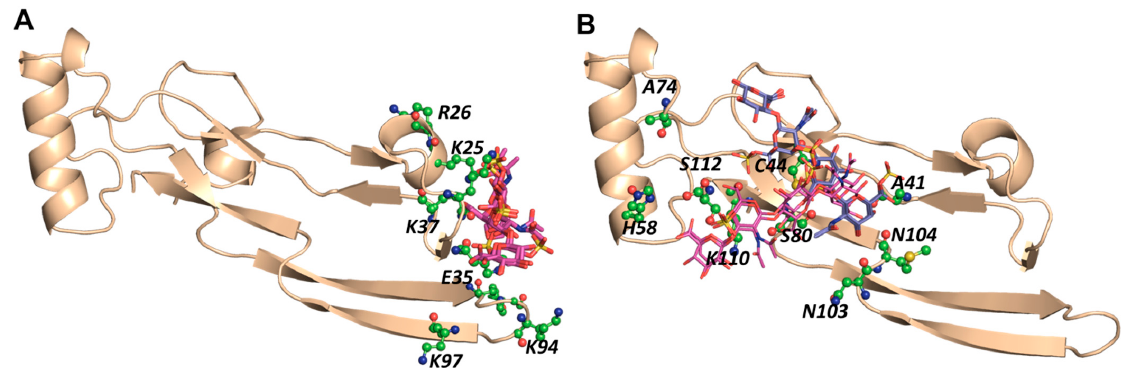
Figure 4. CVLS-predicted tetrasaccharide sequences from the Δ UA NRE , GlcA NRE , and GlcN NRE libraries of CS that prefer to bind to ( A ) BS1 and ( B ) BS2 of TGF- β 2 (magenta and blue colors by atom sticks, respectively). See text for details.